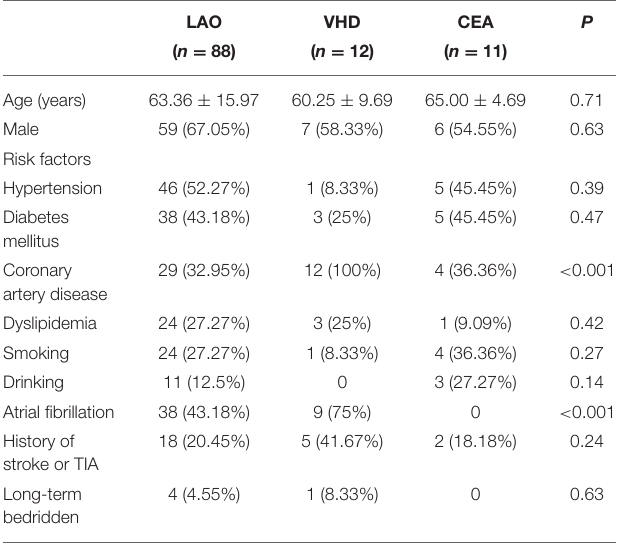
TABLE 1 | Clinical patient